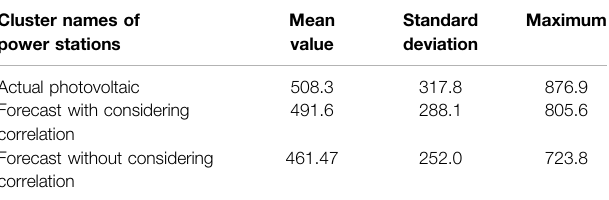
TABLE 3 | Comparison of forecast results with and without considering correlation. Cluster names of power